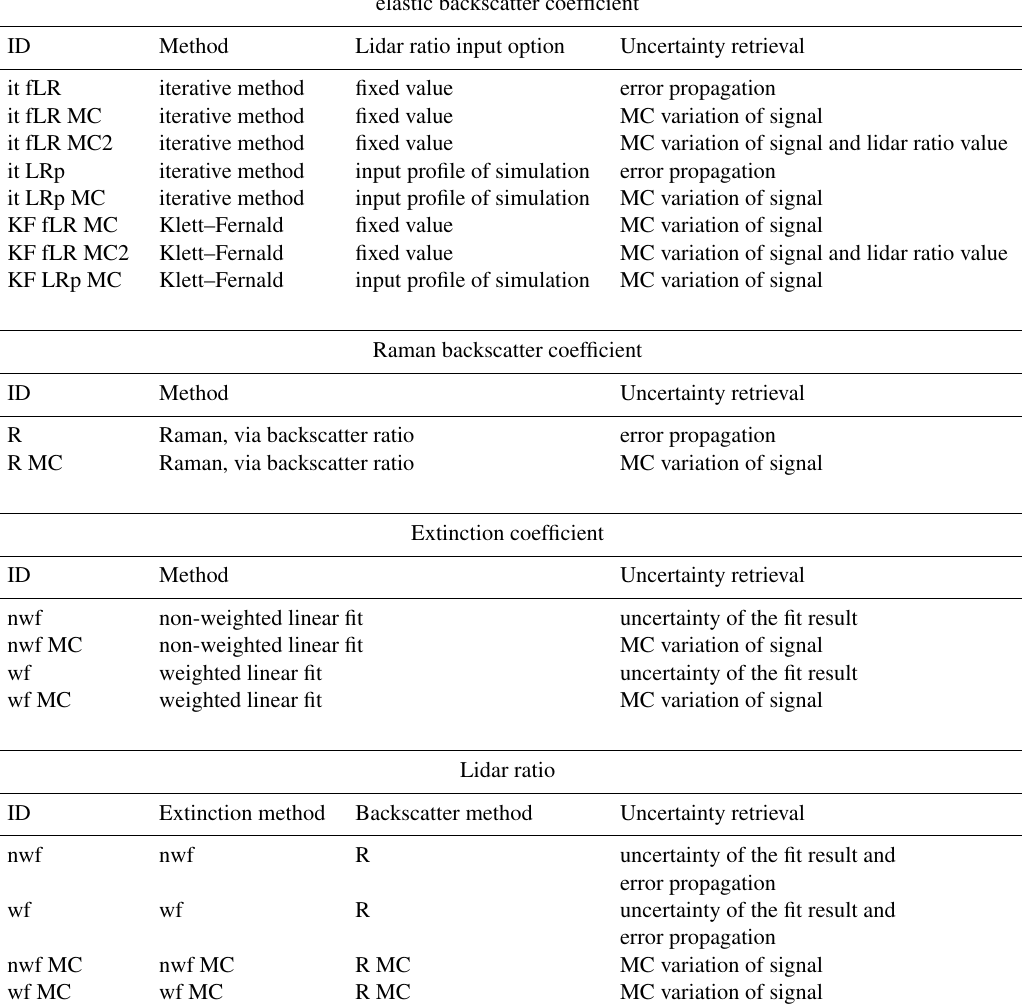
Table 2. List of product types, methods and options for uncertainty retrievals implemented in ELDA. In the validation exercise, all of those products have been tested for 355 and 532nm (see Figs. 11–13, and 15). For 1064nm, only the products listed under “elastic backscatter coefficient” have been tested (see Fig.